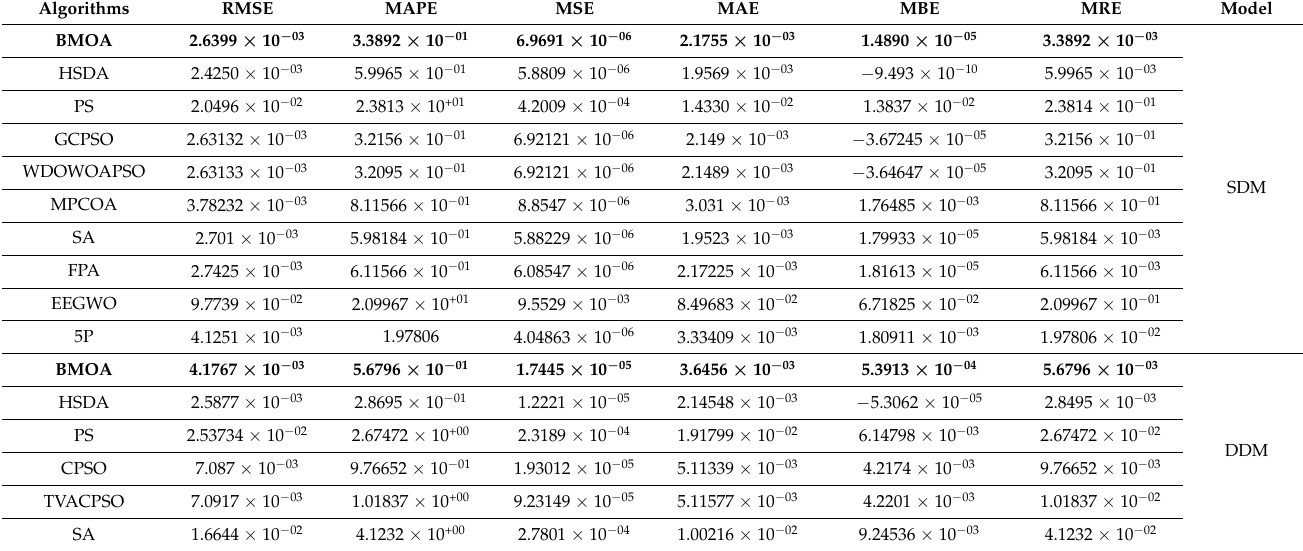
Table 13. PWP201 photovoltaic panel (SDM and DDM) statistical